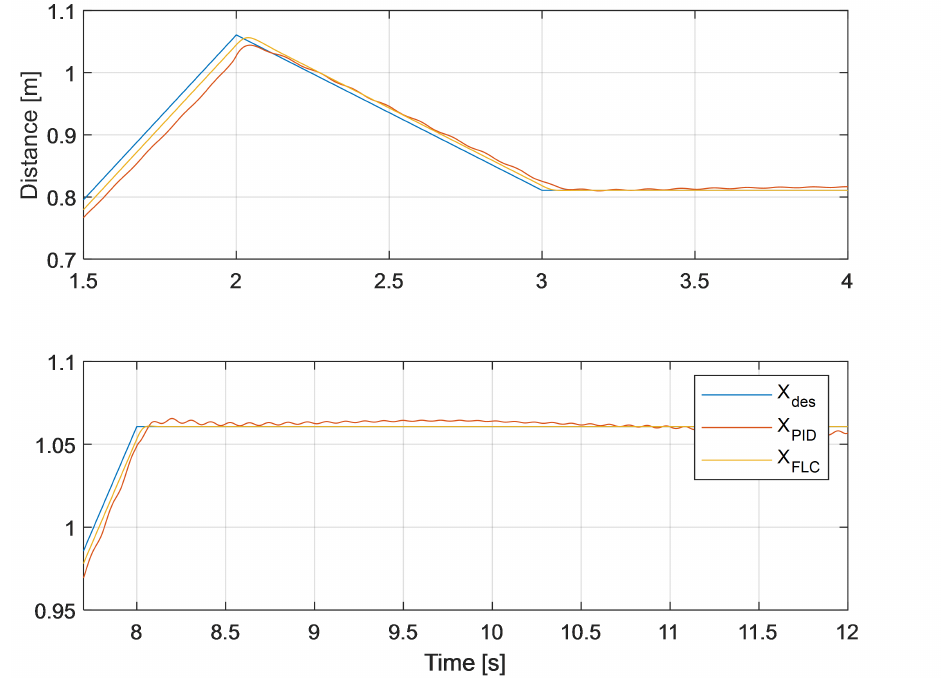
Figure 12. Zoom in a “steady-state”